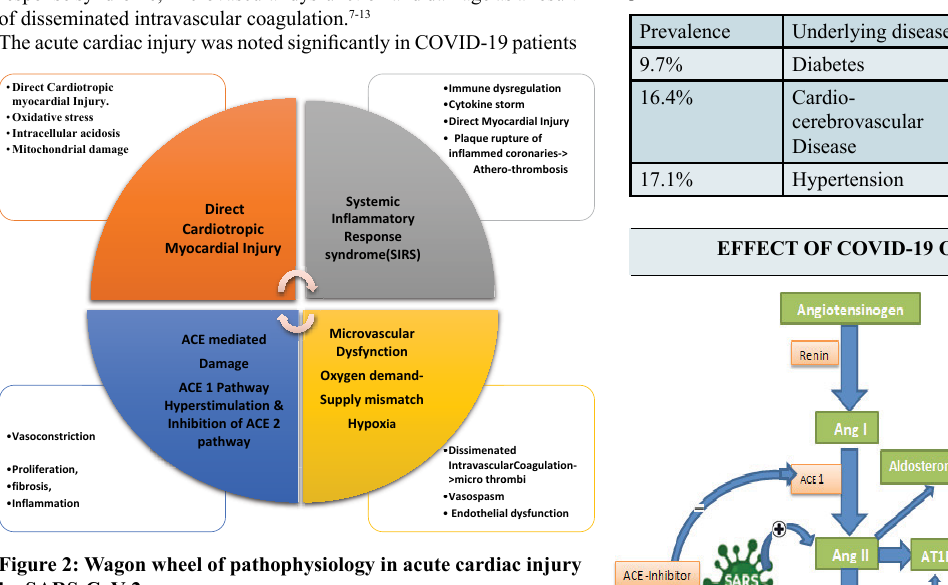
Table 1: Prevalence and case fatality rate in COVID-19 from a meta-analysis of six published studies from China 16,17